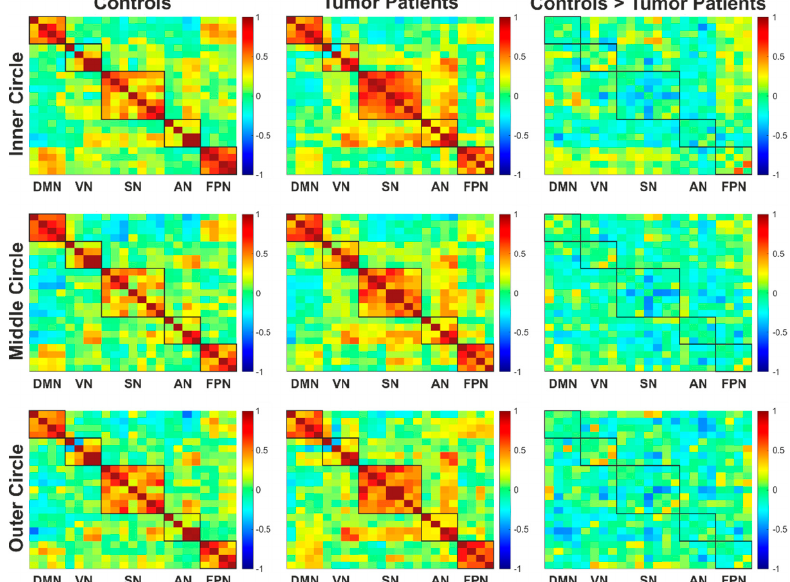
Figure 9. Connectivity matrices of the control group and tumor patient group (each N = 12) and the resulting difference of the controls > tumor patients. The boxes mark the examined networks and the intra-network connectivity they contain. Connections that were more pronounced in the control group are shown in yellow/red, depending on their strength, while those that were more pronounced in the tumor patients are shown in light/dark blue. If there were no differences, this is shown in green. Abbreviations: AN: attention network, DMN: default mode network, FPN: fron- toparietal network, SN: salience network and VN: visual network.